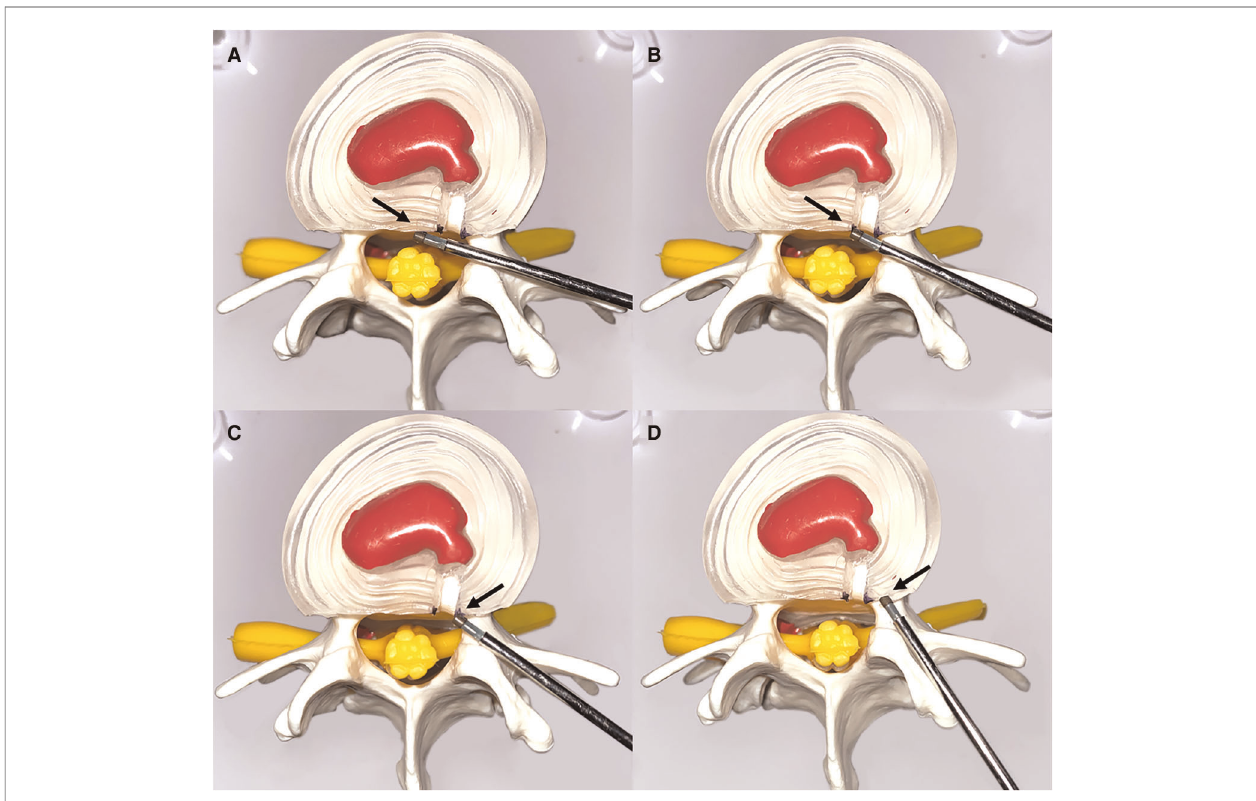
FIGURE 2 | Schematic representation of the denervation of an annulus fi brosus. ( A ) Denervation from the posterior longitudinal ligament (black arrow). ( B,C ) Focused treatment of radiofrequency ablation of an annulus fi brosus dissection (black arrow). ( D ) Final denervation of the annulus fi brosus superior to the vertebral arch (black